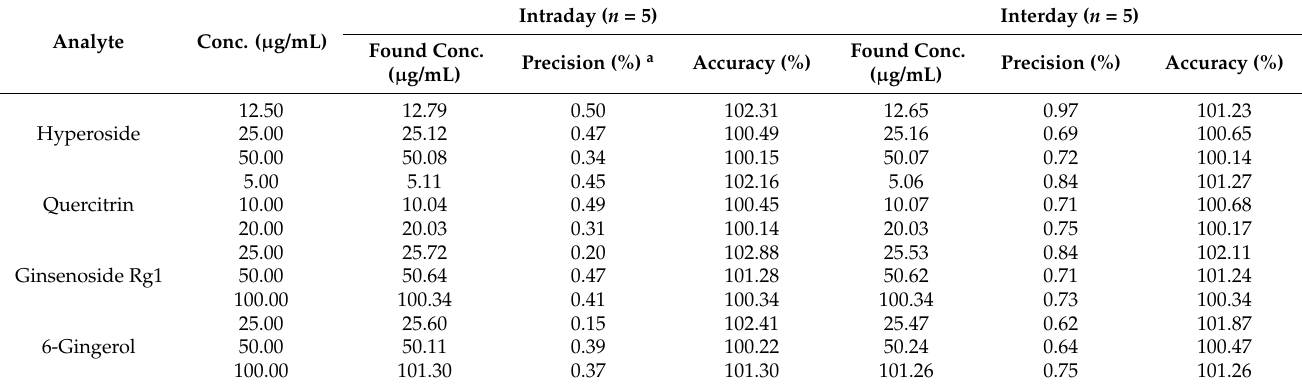
Table 3. Verification of the precision of the analysis method developed using the four marker analytes. Analyte Conc. ( µ g/mL)